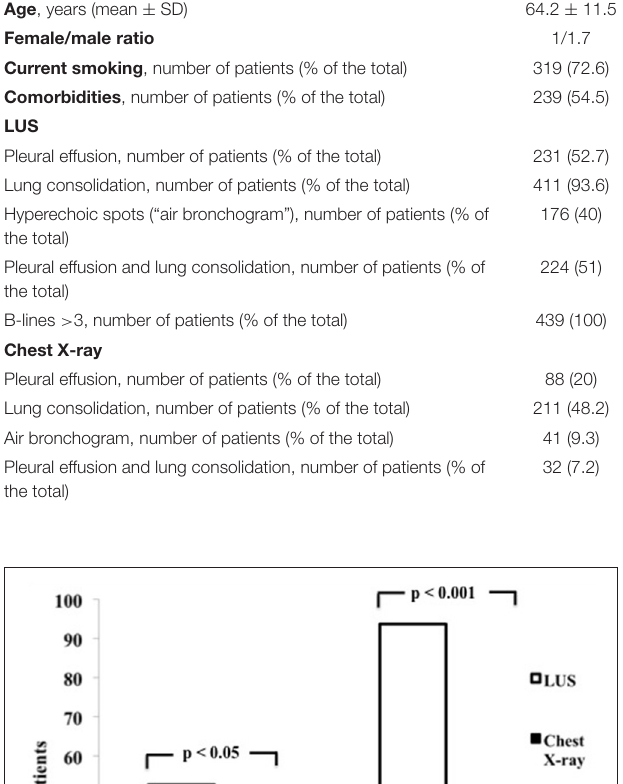
TABLE 1 | Clinical characteristics of patients with dyspnea, LUS and chest X-ray findings ( n = 439). Age , years (mean ± SD)